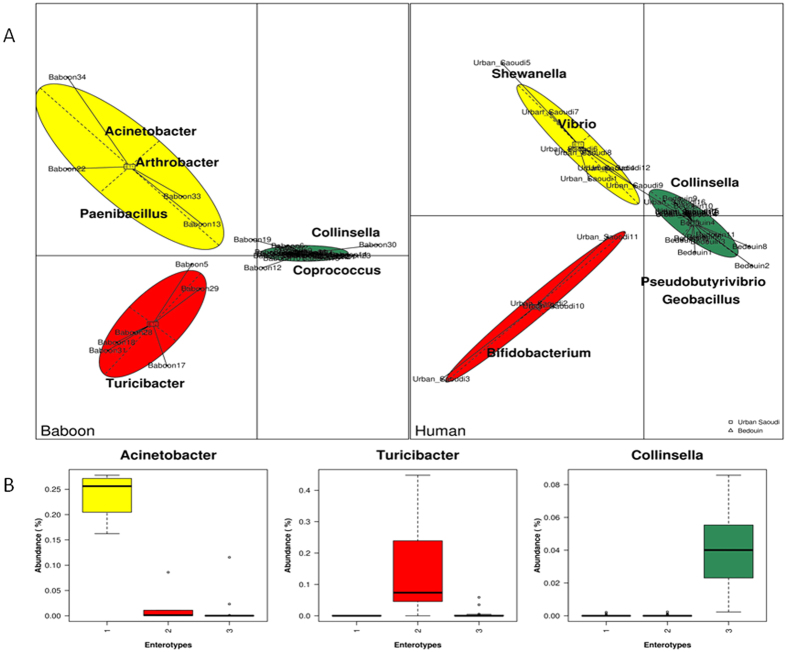
Identification of baboon enterotypes.(A) Assortment of gut microbial communities into enterotypes in baboons and humans. Shown are BCA visualizations of enterotypes (colored ellipses), as identified by PAM clustering, with black dots representing abundance distributions of bacterial genera from an individual host and numbered white rectangles marking the center of each enterotype. Panel (right) showing human gut enterotypes modified from Arumugam et al.3. Bacterial taxa uniquely overrepresented in the corresponding baboon and human enterotypes are listed. (B) Relative abundance of the three bacterial taxa that are principally responsible for the separation of baboon enterotypes. Shown are means, ranges and first and third quartiles.